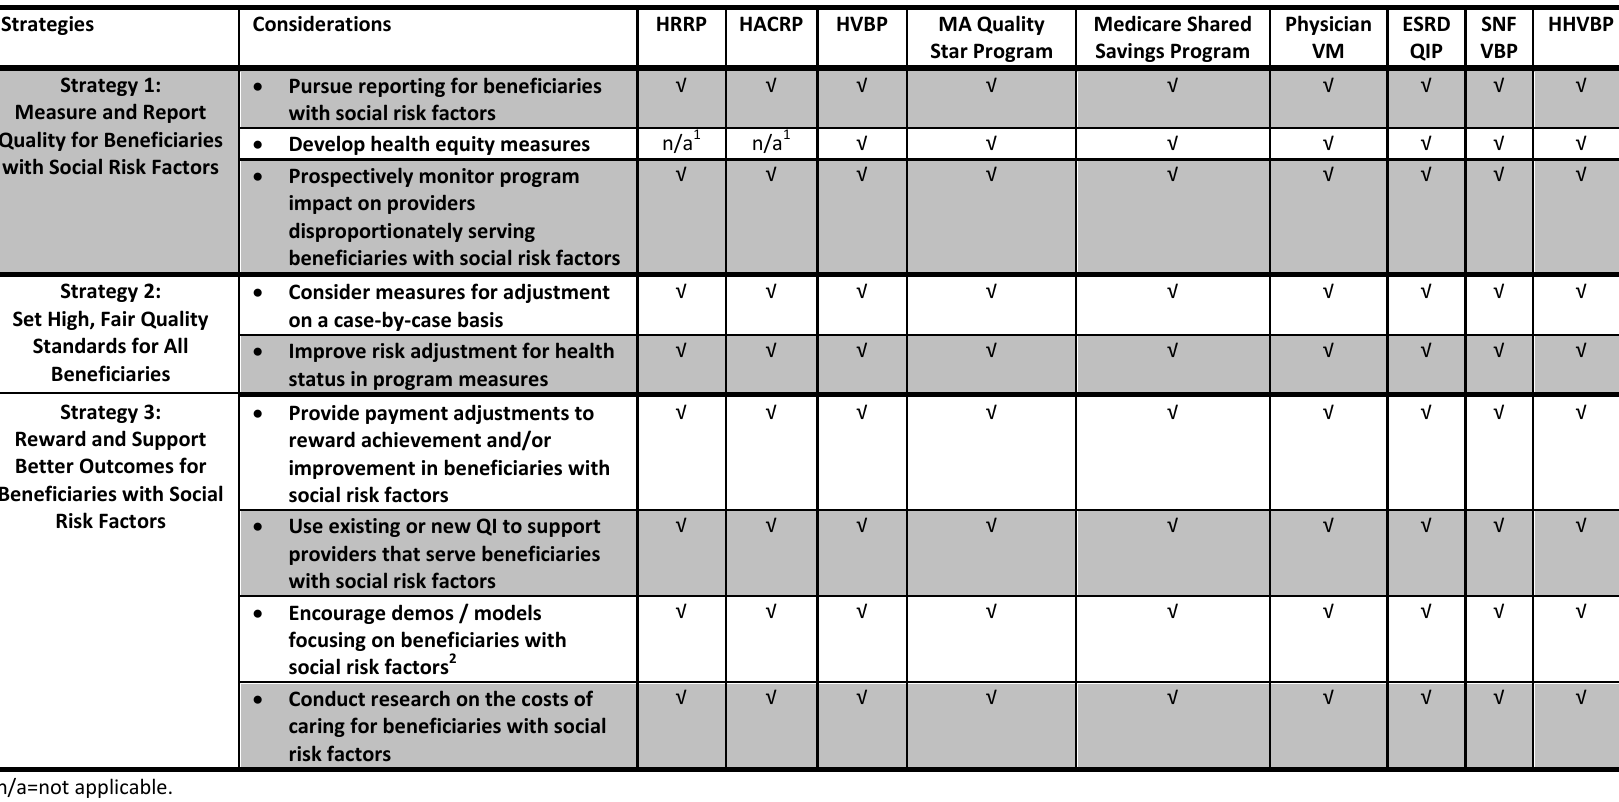
Table 14.4: Application of Considerations to Programs in this report